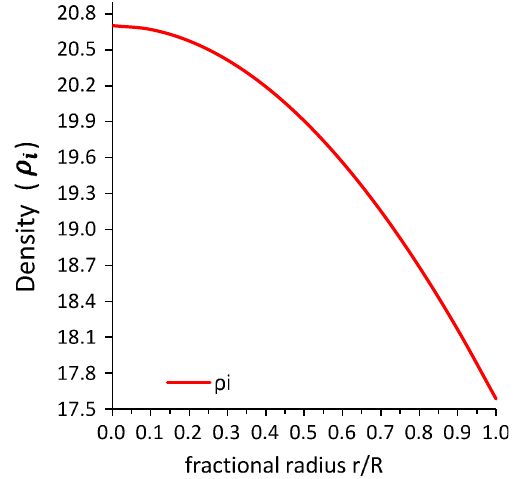
Fig. 2 Behavior of the effective matter–energy density ρ i = 8 π ρ/ C with respect to fractional radial distance ( r / R ) for RX J 1856-37. For plotting this figure we have employed the same data set of numerical values as used in Fig. 1